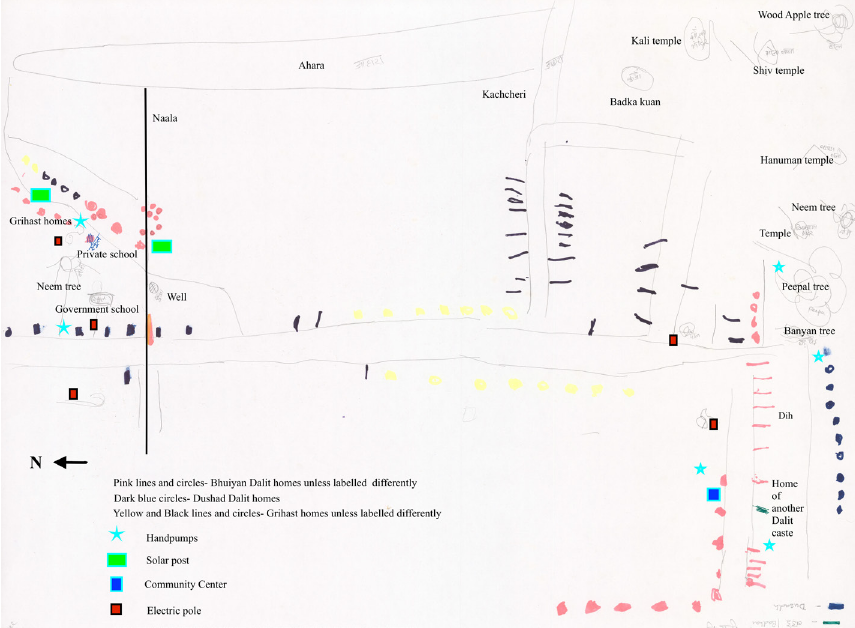
Figure 1: Map of Kaari drawn by Bhuiyan Dalit women showing spatial arrangements of housing, including the dih in the southwest (lower right), and location of resources east of the center of the village (vertical black line at left represents the naala [rivulet]) (December